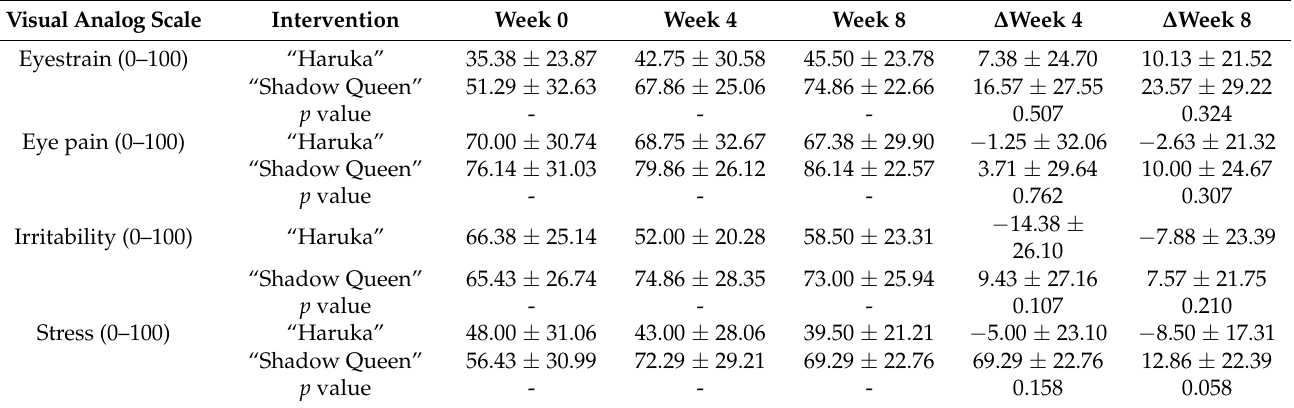
Table 4. Changes in the visual analog scale (VAS) on fatigue as a secondary outcome after taking “Haruka” or “Shadow Queen”.